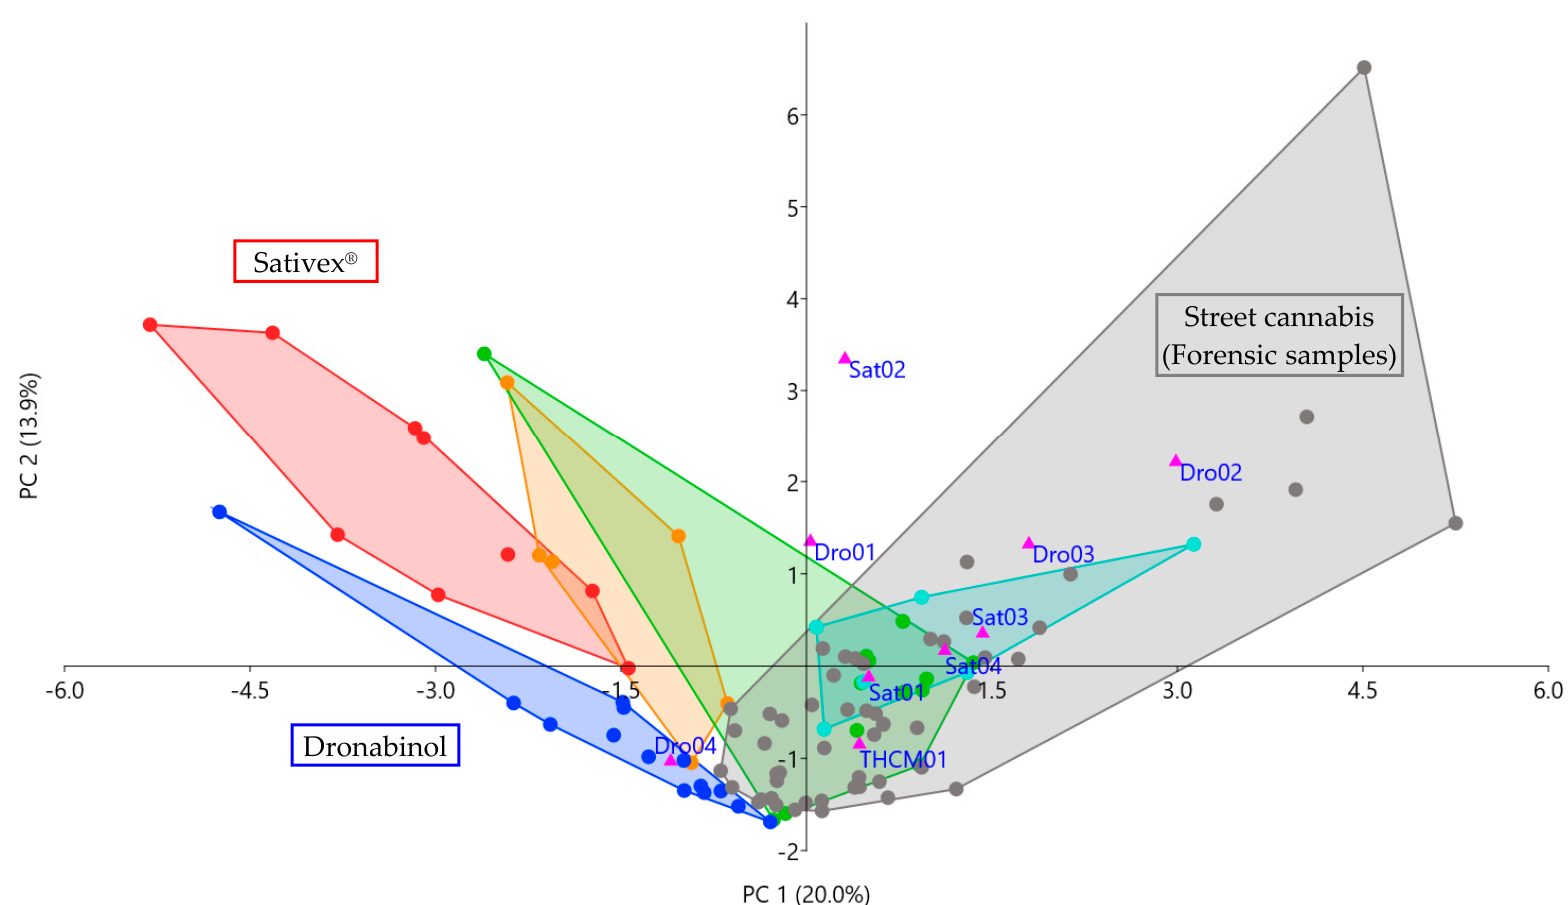
Figure 3. PCA scatter plot of principal component (PC) 1 and PC 2 shows that forensic samples with reported intake of cannabis-based medicines (pink triangles) are mostly plotted among street cannabis user samples (grey dots). Full color code is given in Figure 2. Loadings of PC 1 and PC 2 are given in supplementary Figure S2. Only one sample with self-reported Dronabinol intake (Dro04) was plotted among samples of Dronabinol users (blue dots), indicating similar serum cannabinoid patterns that could indeed result from Dronabinol use. All samples with self-reported use of Sativex ® (Sat01-Sat04) were plotted far from the Sativex ® user sub-collective (red dots) but rather among forensic samples, suggesting (additional) use of cannabis or cannabis-based products with notable quantities of minor cannabinoids.